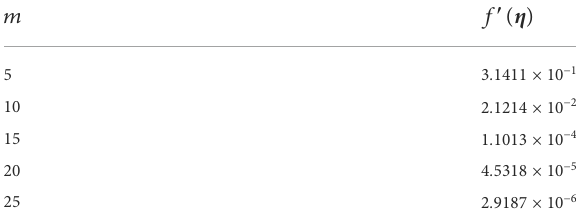
TABLE 2 Convergence of the de fi ned problem for the velocity equation; from table 2, we noted that as we increase the number of iteration, the residual error decreases and strong convergence is obtained.